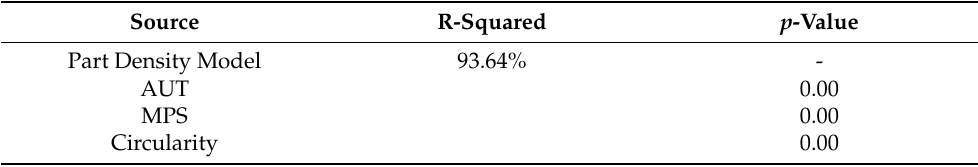
Table 4. Summary statistics for the Surface Roughness MLR